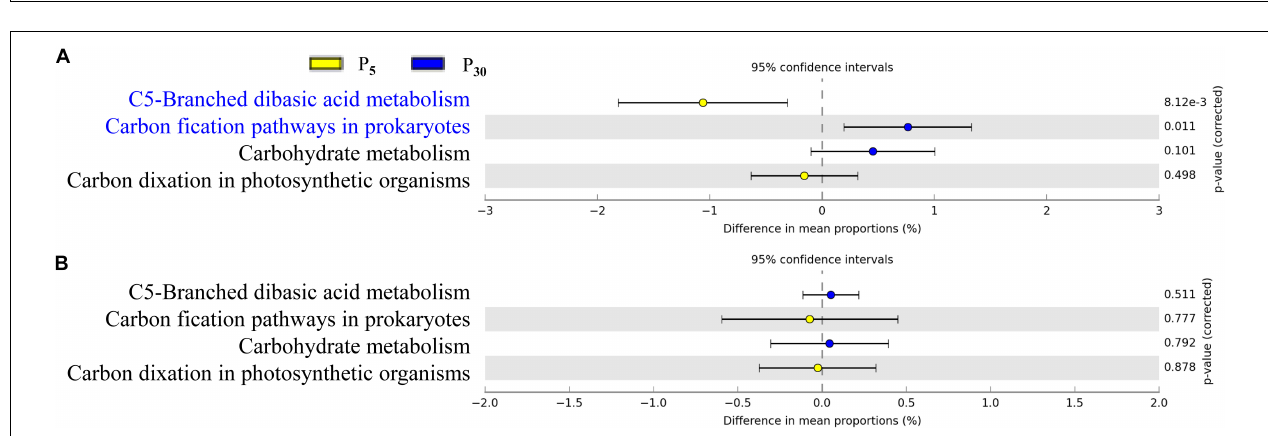
FIGURE 5 | Operational taxonomic unit enrichment in the rhizoplane of maize and clover roots. The ternary plot depicts the rhizocompartments (rhizoplane, rhizosphere, and bulk soil). Relative abundance of all OTUs ( > 0.05%) in at least one sample in (A) maize or (B) clover ( n = 72). Each point corresponds to an OTU. The size of each circle represents its relative abundance, and the position of each circle is the contribution of OTUs in the indicated compartment to the total relative abundance. Orange and green circles marked OTUs enrich in rhizoplane, rhizosphere, whereas gray circles represent OTUs that are not significantly enriched. A Venn diagram comparing differentially enriched OTUs in the rhizosphere relative to bulk soil, and rhizoplane relative to rhizosphere in (C) maize and (D) clover plants. The number in the overlapping part of the circles depicts the consecutive OTUs from rhizosphere to rhizoplane. (E) The relative abundances of the consecutive enriched OTUs account for rhizoplane, rhizosphere, and bulk soil, respectively.